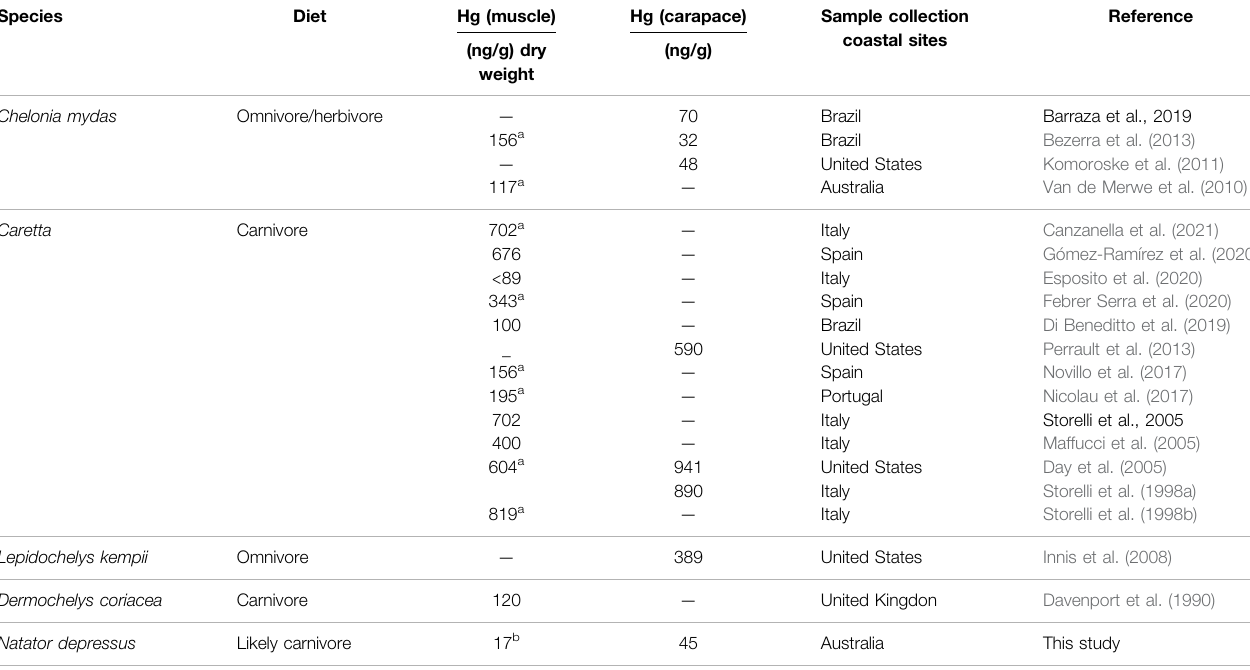
TABLE 2 | Total mean Hg concentration (ng/g) in muscle/skin and carapace of sea turtle species worldwide and in fl atbacks from this study. Species Diet Hg (muscle) Hg (carapace) Sample collection